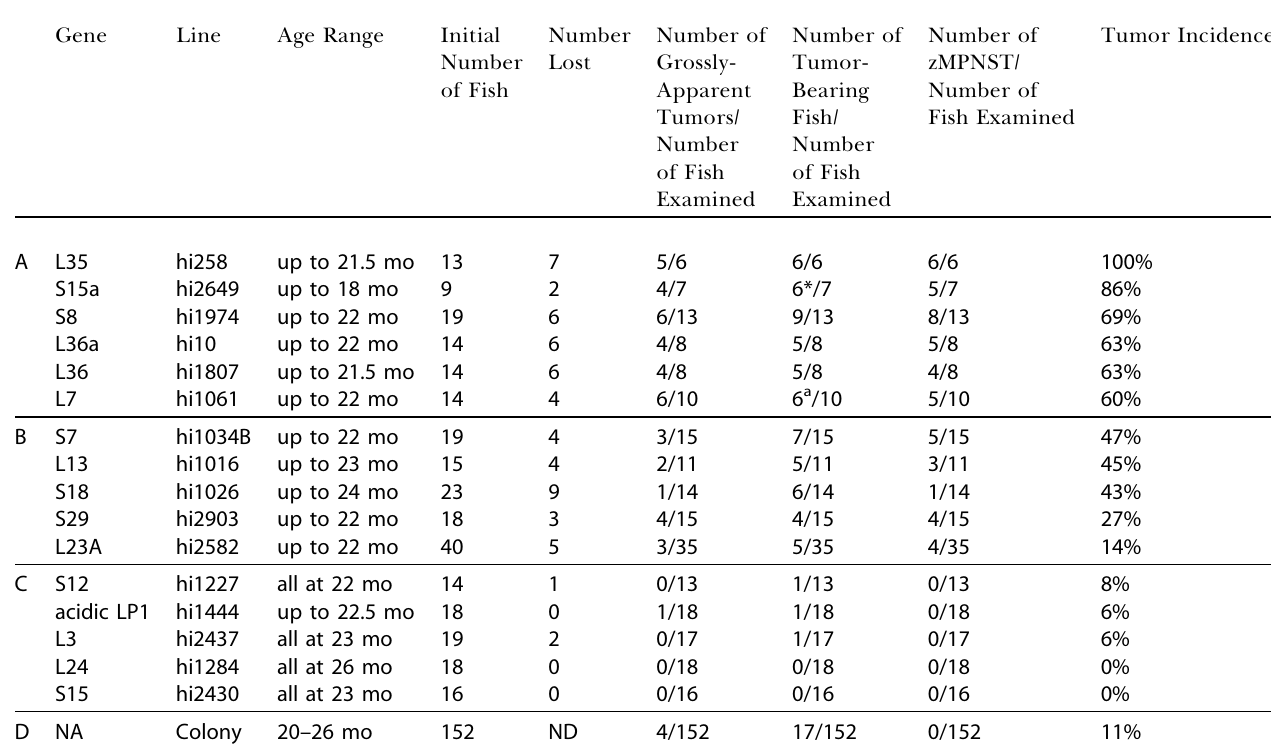
Table 1. Tumor Incidence in Zebrafish RP-Heterozygous Lines and in the Colony Gene